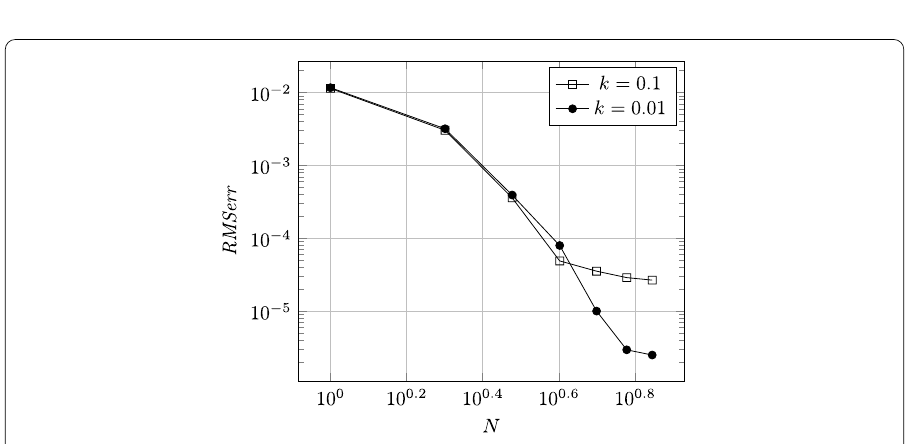
Figure 4 The RMS err as a function of N , k = 0.1,0.01 for Example 5.1